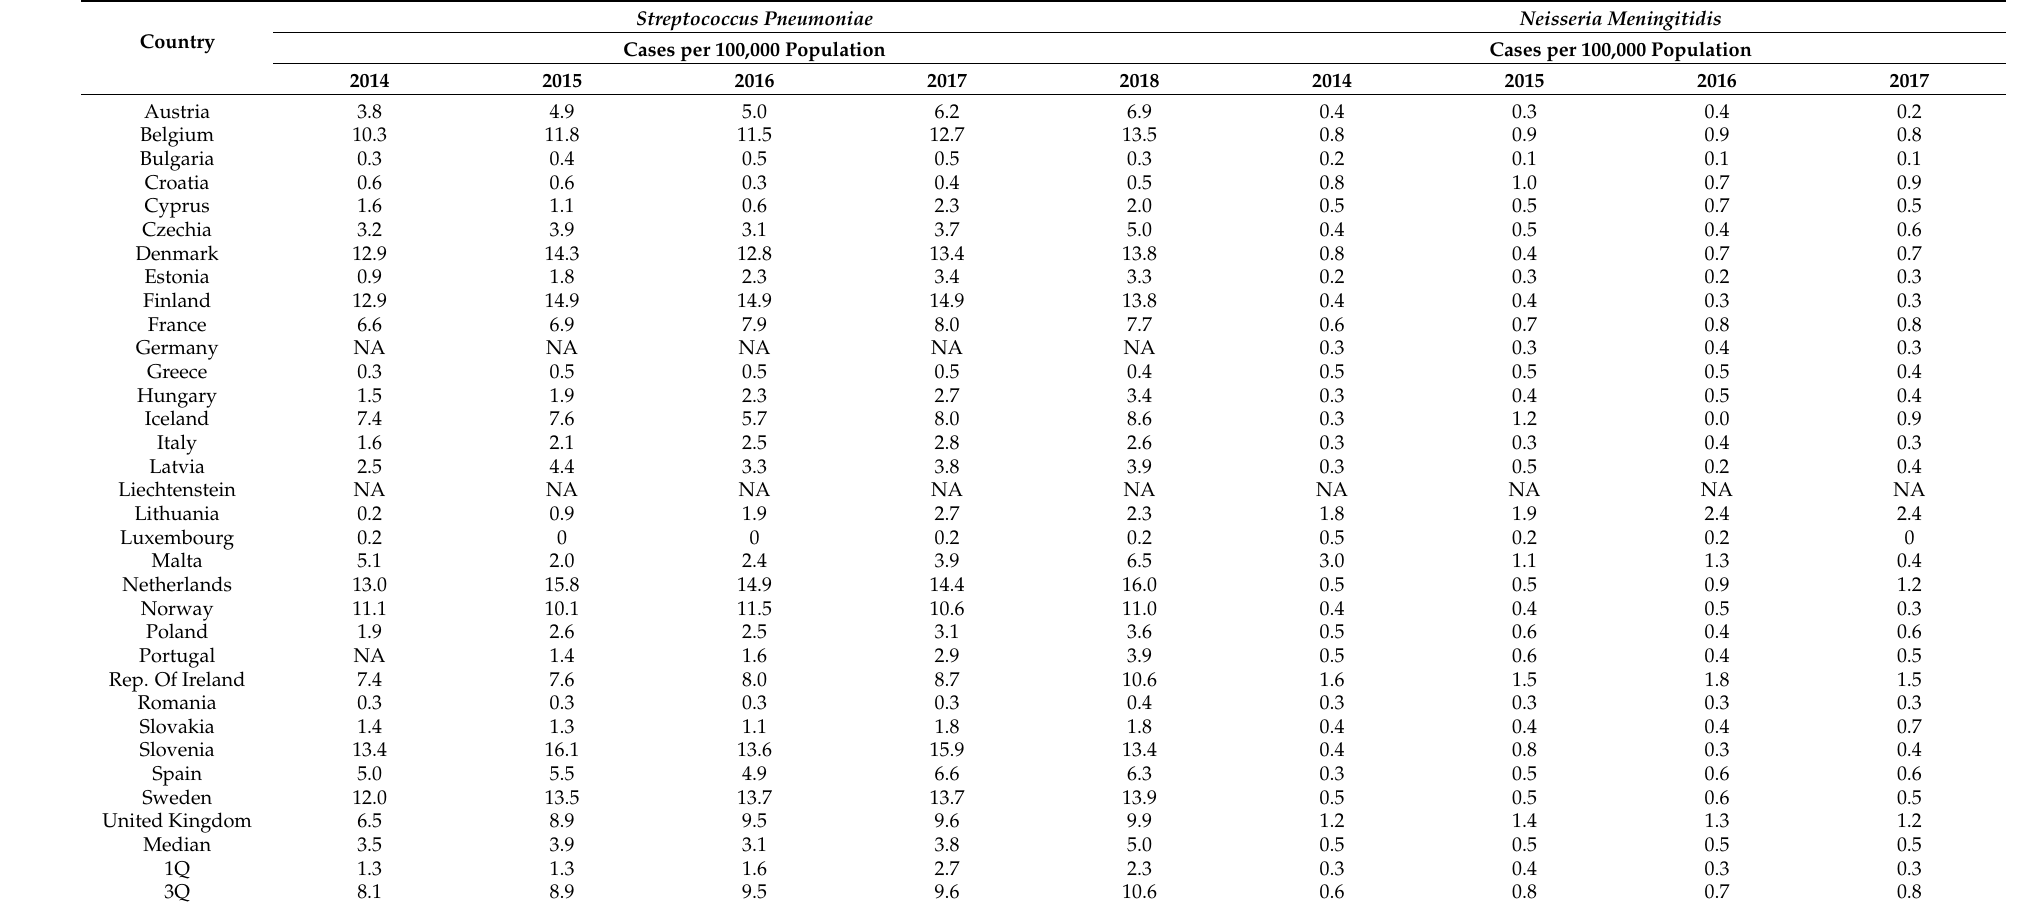
Table 2. Incidence of Streptococcus pneumoniae and Neisseria meningitides in the EU and EFTA countries in selected years.